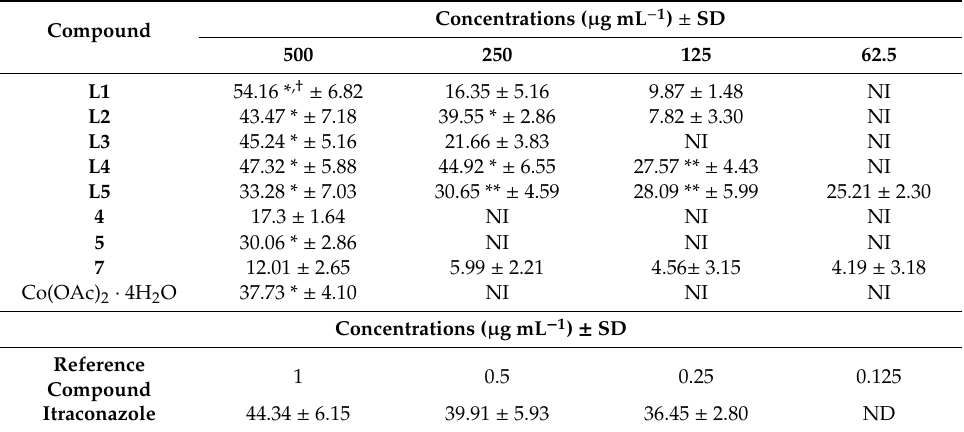
Table 5. Inhibitory activity against Candida albicans germ tube formation.